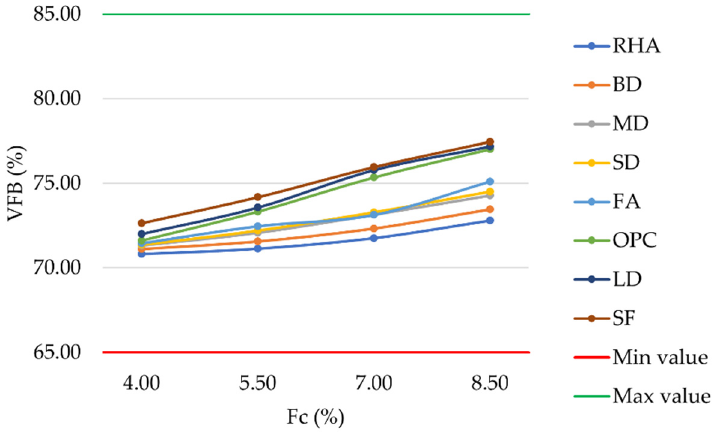
Figure 5. Voids in the mineral aggregate vs. filler content for mixtures prepared with conventional and waste fillers.